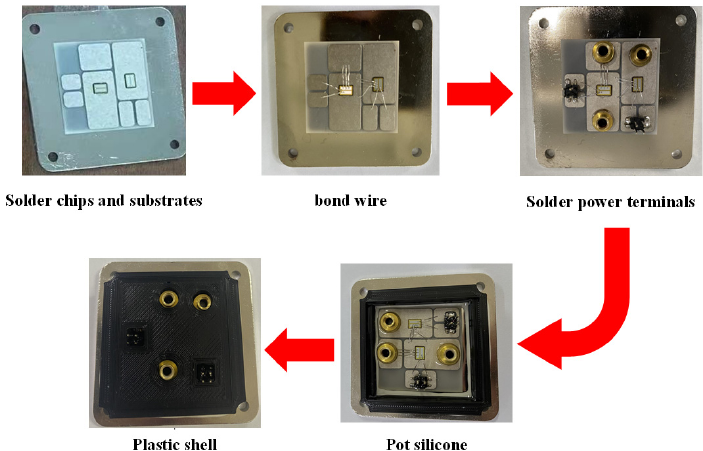
Figure 12. The fabrication process of the SiC MOSFET half-bridge power module.